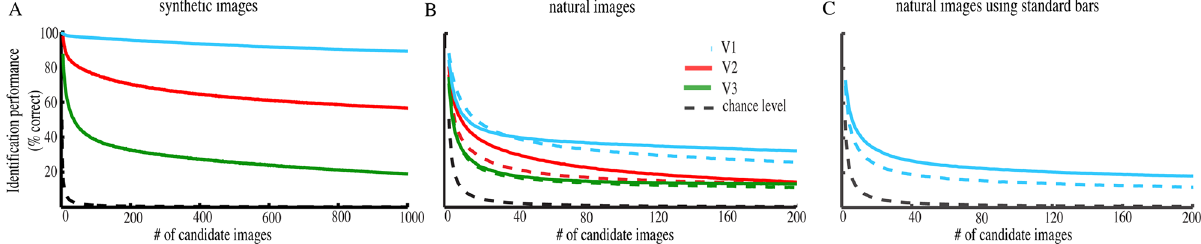
Fig 5. Image identification performance both for synthetic (A) and natural image stimuli (B, C). The pRFs were estimated in a separate scan where the bars were filled with synthetic (A, C) and natural (B) stimuli either in the same session (A,B) or in different sessions on different days (C). The blue, red and green lines show the performance for visual field maps V1, V2 and V3 respectively,for 2 subjects (closed and dashedcolored lines). The thickness of the lines includesthe 95% confidenceintervals. For the synthetic image stimuli we increasedthe set size up to 1000 different images, for the natural images we increasedthe set size up to 200 different images. The black dashed line indicatesthe chance level. The high-contrast synthetic images were most accuratelyidentified(A), and the natural images were also identifiedfar abovechance for all candidate image set sizes (B). Furthermore, the identification of the natural images is also possible with the pRF-modelthat was estimated using standard bar stimuli containing moving checkerboards, and estimated from a separate scanningsession on a separate day